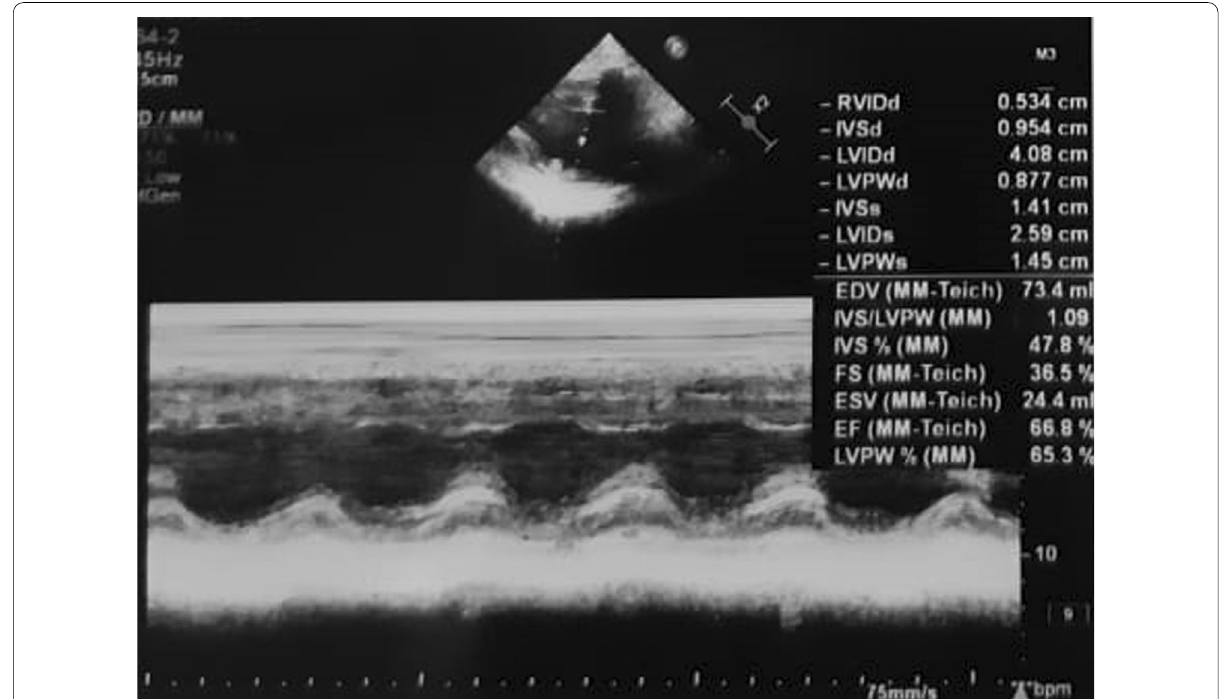
Fig. 3 Echocardiograph before outpatient showed no hypokinetic with normal EF